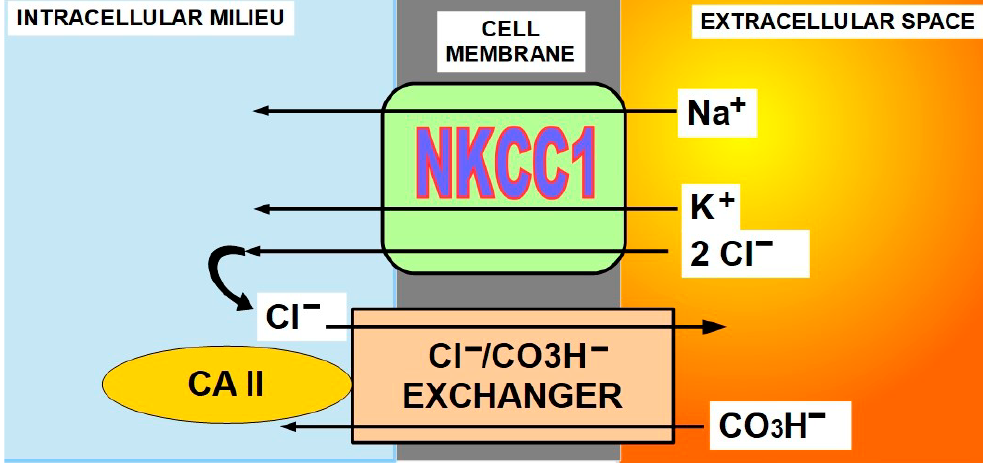
Figure 7. The tandem work of NKCC1 and the Cl/CO3H exchanger alkalinize the intracellular